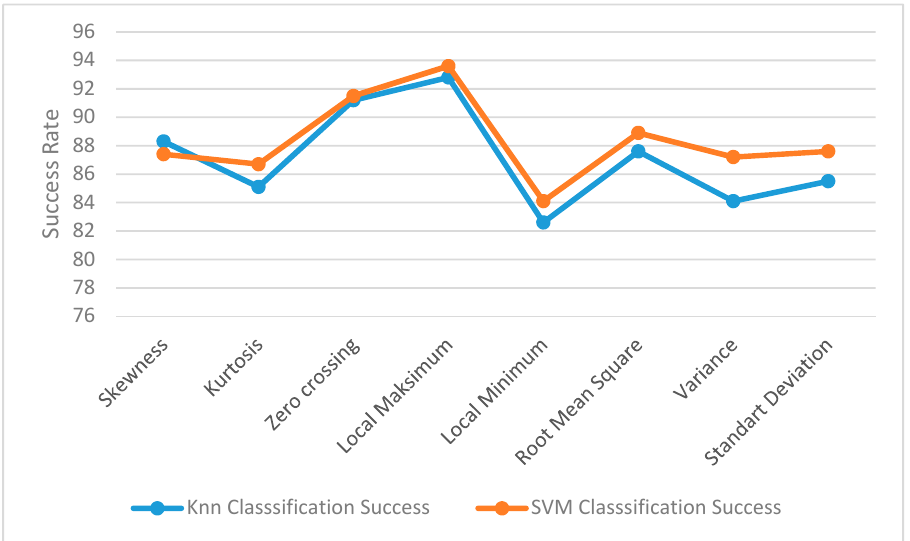
Figure 4. Knn’s and SVM’s Classification Success of Feature Extraction Methods (SVM: Support Vector Machine; Knn: K Nearest Neighborhood).